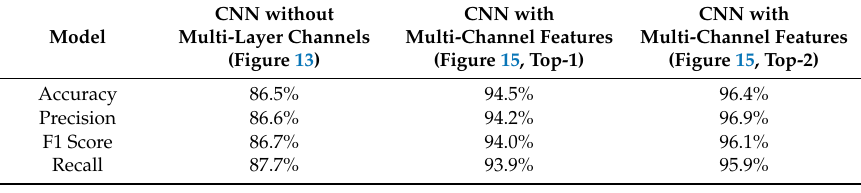
Table 2. Comparison of our novel model’s classification performance through different traditional metrics.